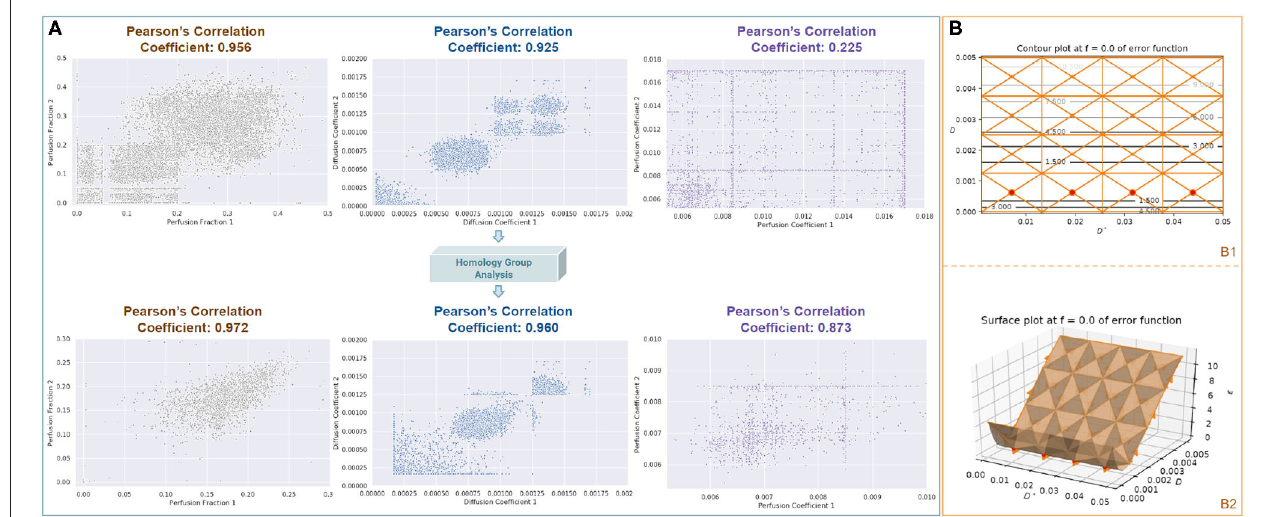
FIGURE 7 | (A) Here, we demonstrate the test-retest reliability of the TopoPro algorithm. On the same data, we split the data in half by choosing alternating b -values. We show using an inverse penalty function that we can improve the stability across all parameters. We plot the first half of the data-split along Y-axis and the other along X-axis. Notice how the reliability (Pearson Correlation Coefficient) improves across all parameters calculated for each parameter, i.e., Perfusion Fraction ( f ), Diffusion Coefficient ( D ), and Perfusion Coefficient ( D ∗ ). (B) We use the simplicial homology optimizer to show the infinite solution space of D ∗ at a particular value of D when f = 0. This has been depicted with the surface plot of simplicial complex (B1) and its corresponding contour plot (B2) . Notice that all values in the solution subspace for D ∗ are equally good in this case, making it hard for the optimizer to find a